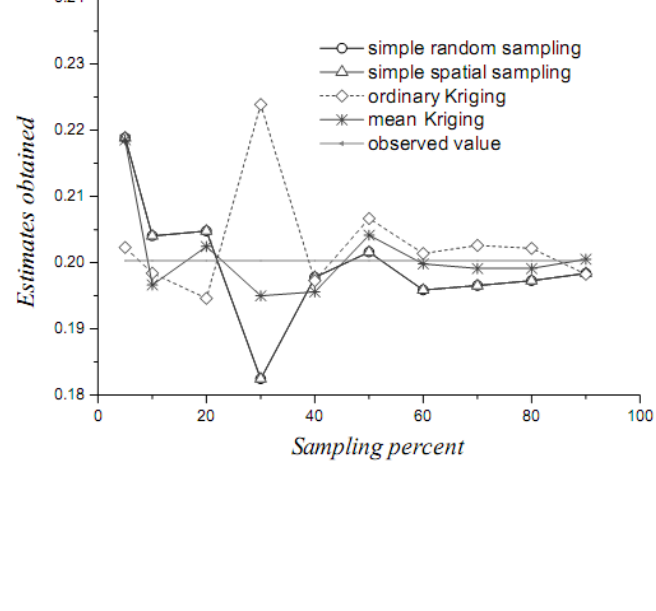
Figure 10. Estimates of the cultivated land OSPM by various